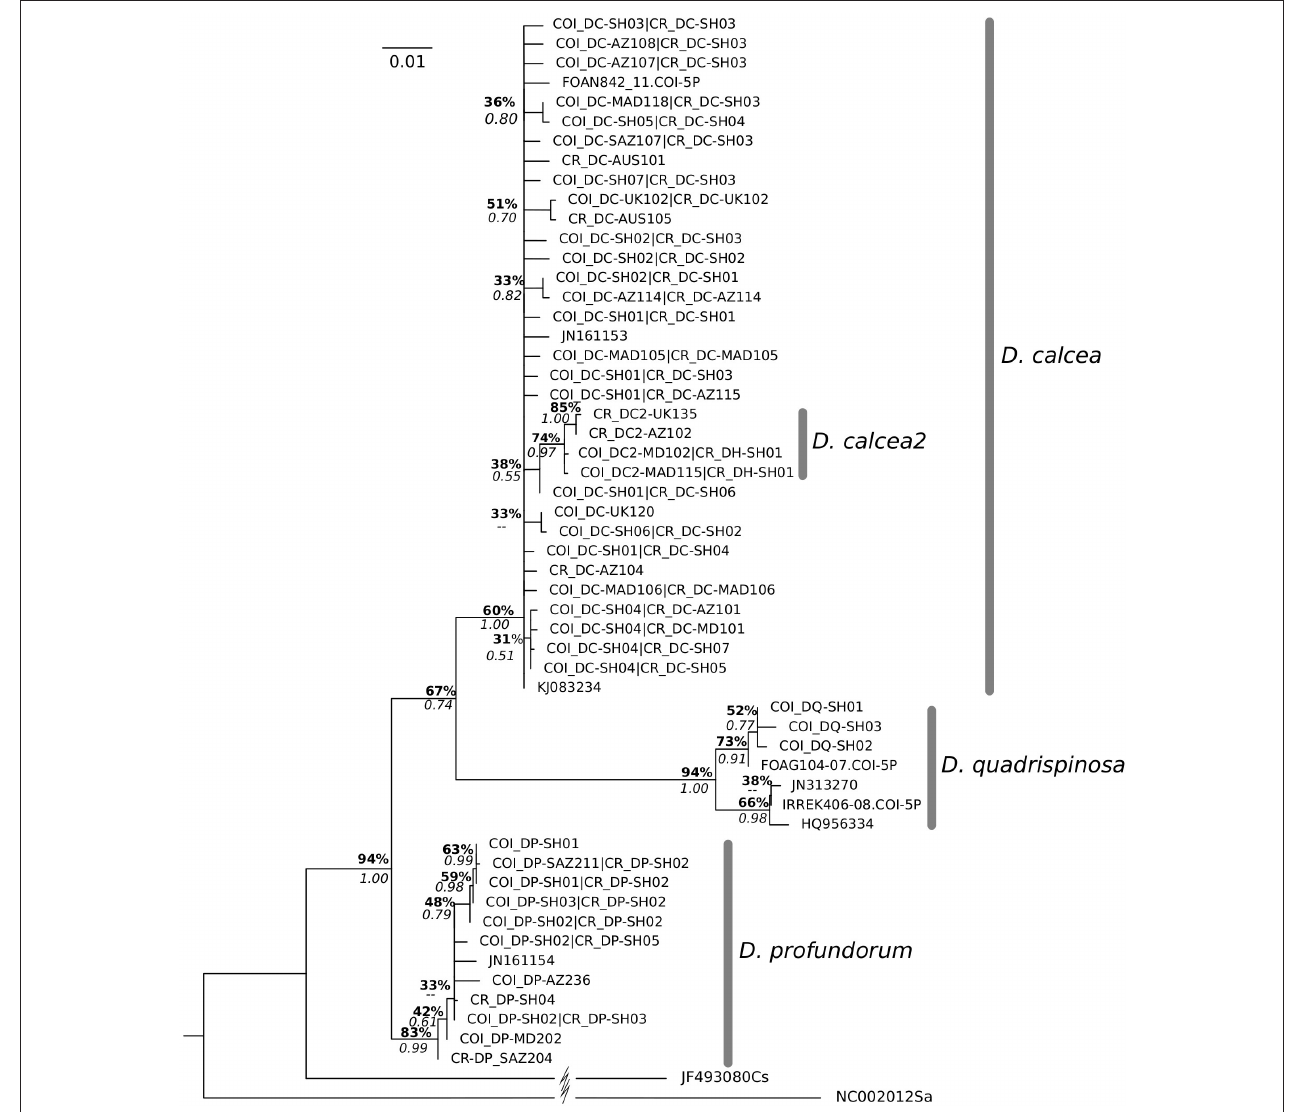
FIGURE 2 | Bayesian phylogenetic tree of Deania species obtained using concatenated sequences (COI and CR). The scale bar indicates the number of substitutions per site and values at branches represent Bayesian posterior probabilities and bootstrap values obtained for the Maximum Likelihood tree. Nodes where Bayesian posterior probability was under 0.50 are not